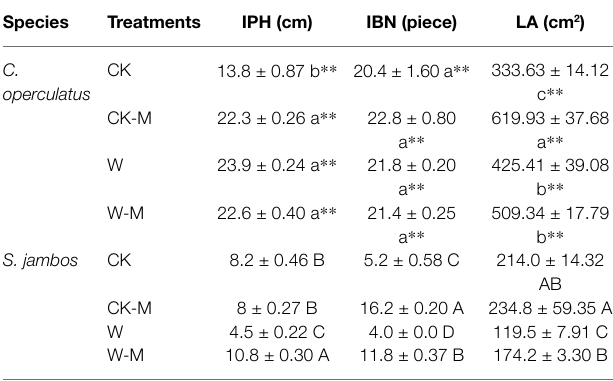
TABLE 1 | The variations of IPH (increment in plant height), IBN (increment in number of blades), and LA (leaf area) in Cylindrocopturus operculatus and Syzygium jambos among different